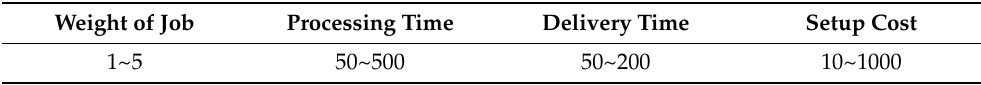
Table 1. Parameter of input data in small-scale